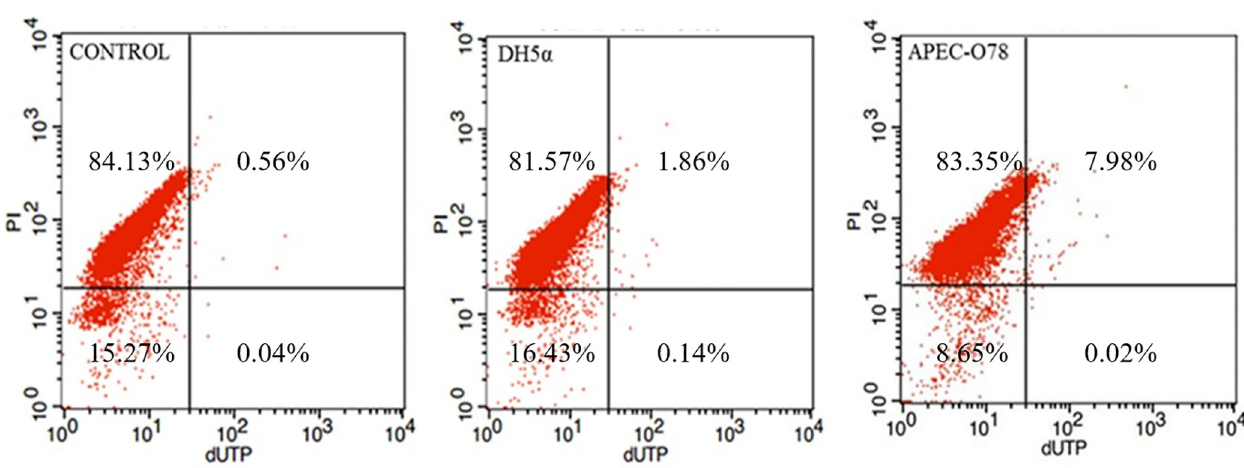
Fig 7. The apoptosis rate of APEC-O78-induced CP II cells. The CP II cells infected by APEC-O78 and DH5 α were at a MOI of 100 for 4h. Then the cells were stained using the TransDetect Annexin V-FITC/PI Cell Apoptosis Detection Kit. Finally, the cells were analyzed with a FACSCalibur flow cytometer.